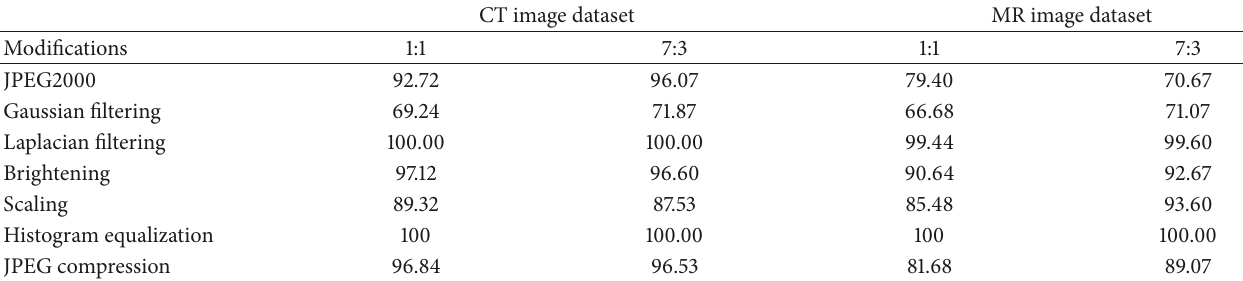
Table 6: Multiclass detection rates (%) of HRBK with different training and testing sets ratios. CT image